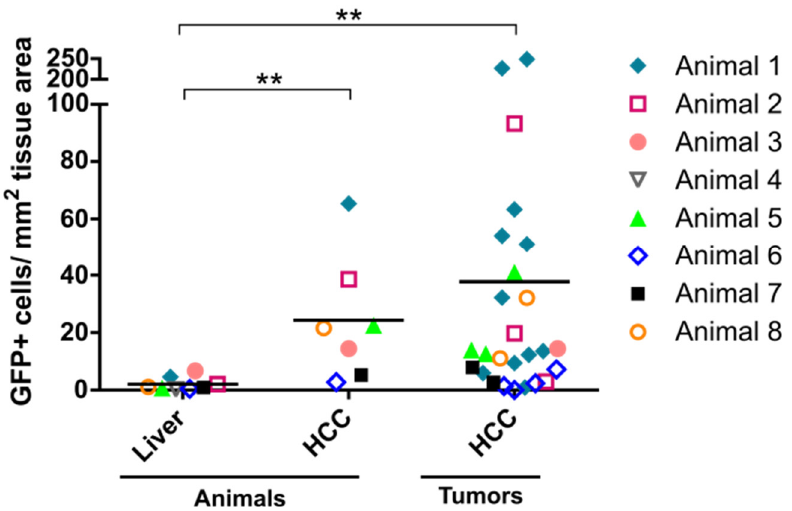
Figure 4. Transgene-expressing cells in liver and liver tumor tissue of TGFα/c-myc HCC mice. eGFP- positive cells in the liver and tumors were quantified per tissue area in mm 2 . Samples belonging to the same animal are labeled by the same symbol. Data are derived from the same animals as in Figures 1–3 and are shown in linear scale as mean cells/mm 2 per animal and mean cells/mm 2 per individual tumor with grand mean within each cohort. Data are shown in linear scale. Statistics: Cohort sizes account for the Shapiro–Wilk normality test ( p < 0.0001); Shapiro–Wilk normality test with log 10 -transformed data ( p ≤ 0.0249). Kruskal–Wallis test ( p = 0.002) and Dunn’s multiple com- parisons test with “Liver” as control cohort (** p < 0.01). N (liver) = 8 animals; N (HCC) = 7 animals; n = 26 tumor lesions.